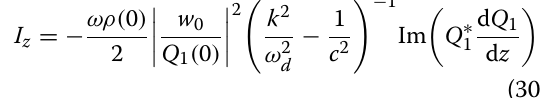
In an atmosphere without dissipation, I z is constant, and the right side of Eq. (30) should be independent of z